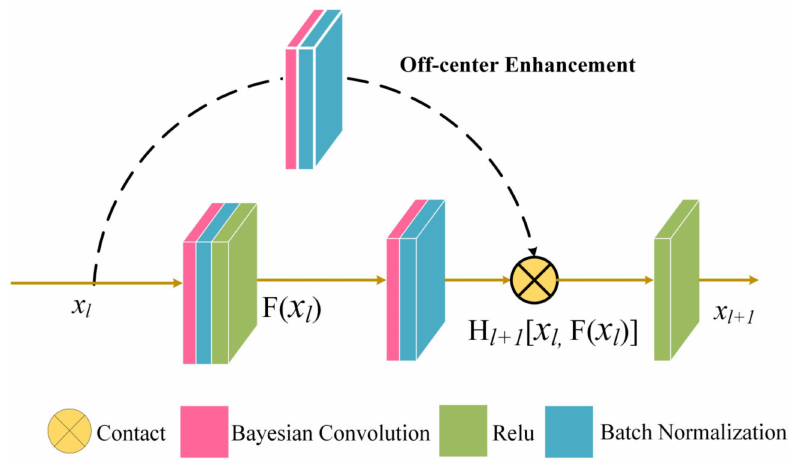
Figure 6. Off-center enhancement